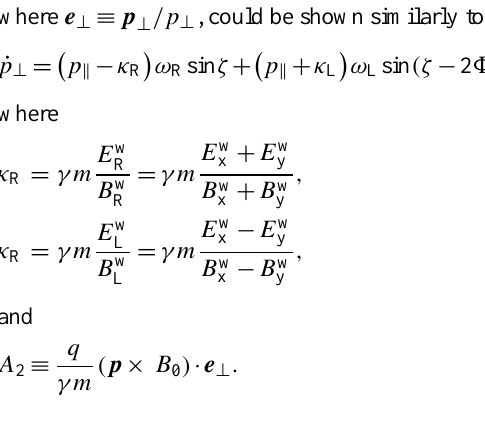
Fig. 1. An illustration of the relative positions of wave fields B R and B L and particle’s perpendicular momentum p ⊥